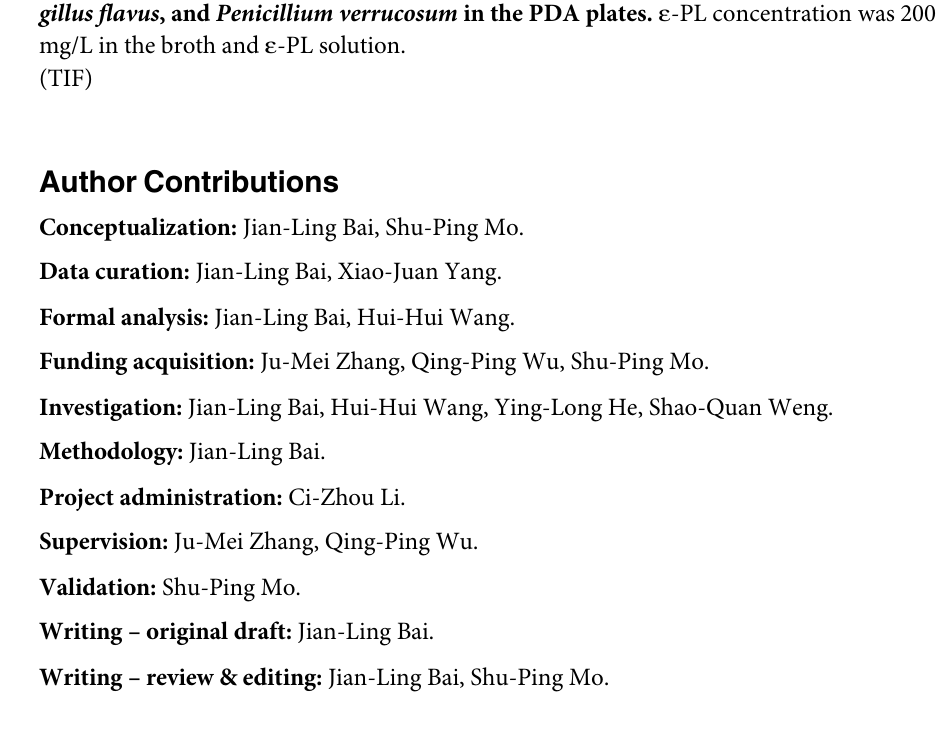
S1 Fig. In vitro antifungal activity of ε -PL broth against Pestalotiopsis microspora ,